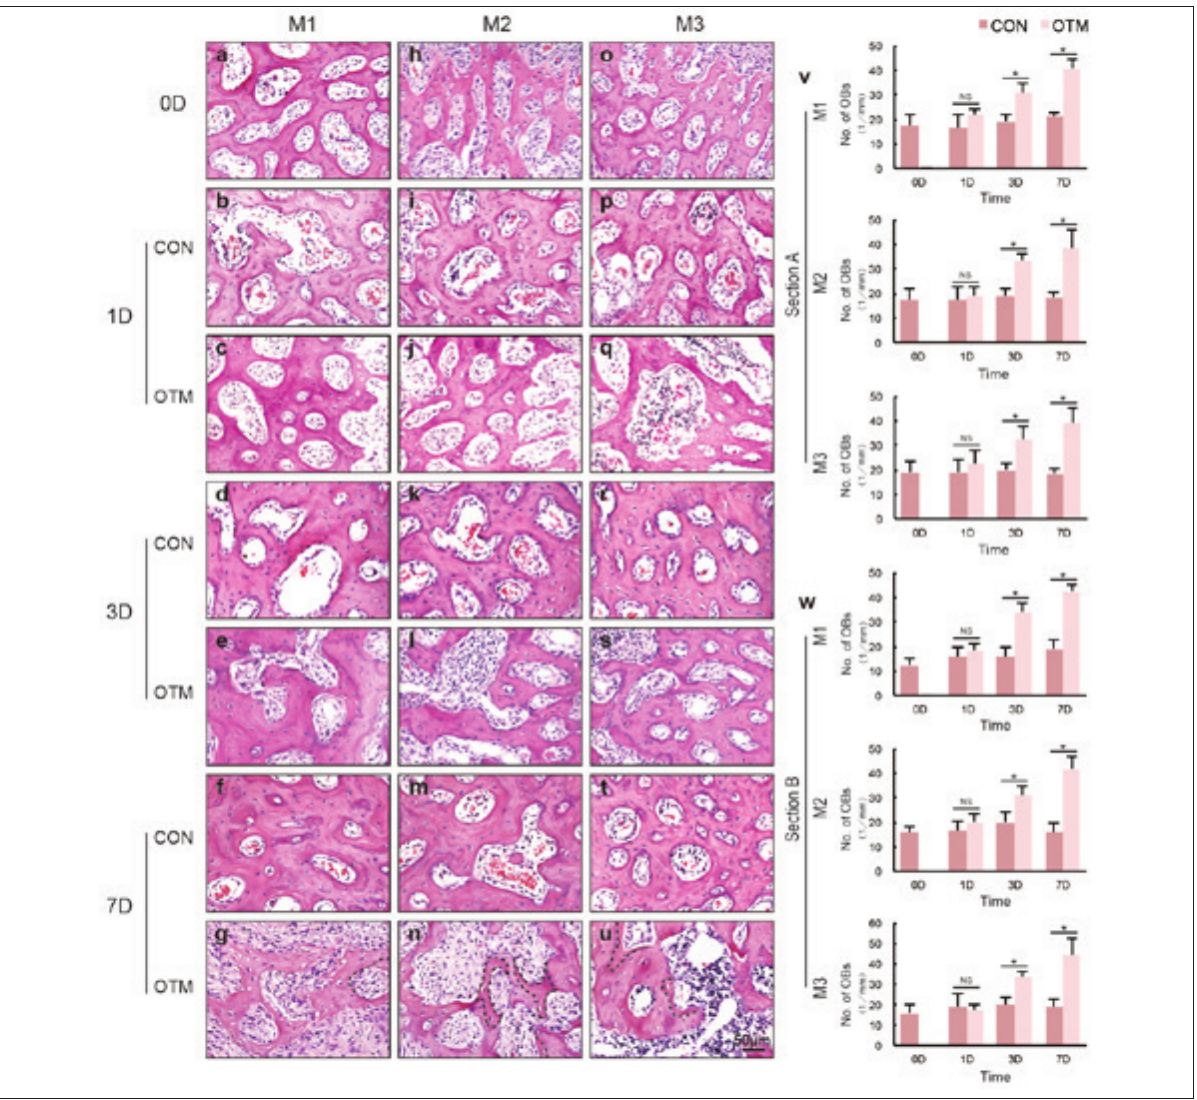
Figure 4. The local orthodontic force acting on the first molar initiated the entire bone formation remodelling of the hemi-maxillary bone. H and E staining of the maxillary alveolar bone. The dotted line showed the boundary of newly formed bone. (* p < 0.05; NS: no significant difference, p > 0.05; N =